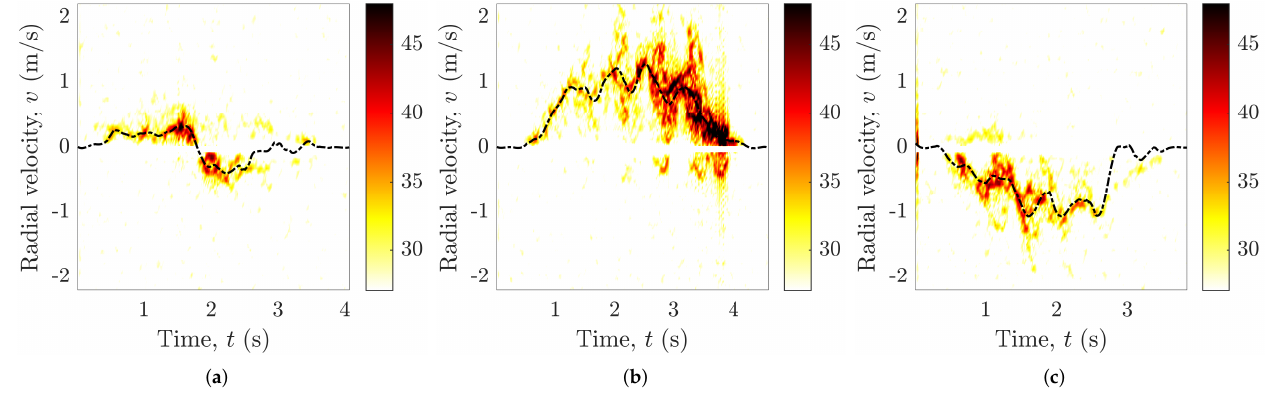
Figure 9. For Radar 2 , the measured radial velocity distribution p 22 ( v , t ) and mean radial veloc- ity ¯ v 22 ( t ) of a human walking activity in ( a ) Scenario 1, ( b ) Scenario 2, and ( c ) Scenario